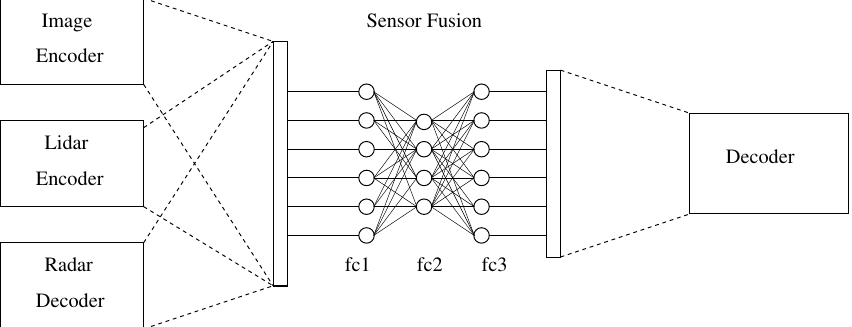
Figure 8. The architecture model consists of three decoder sub-networks, one for each sensor, a fully connected neural network, and a decoder. Table 1. Encoder network